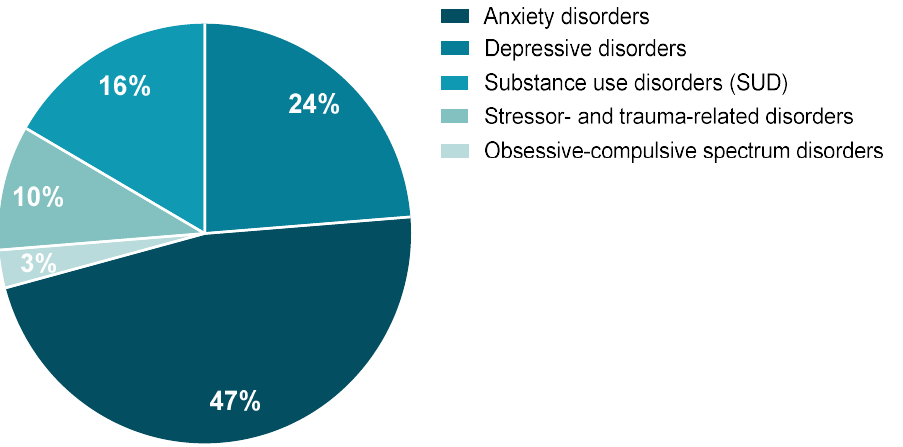
Figure 6. Estimated percentage of each of the five stress-related disorders of interest represented as part of a whole. Data were reanalyzed from the prevalence published in